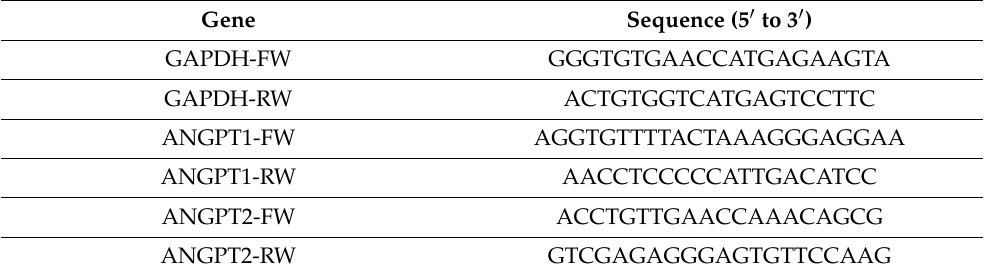
Table 1. Primer sequences for